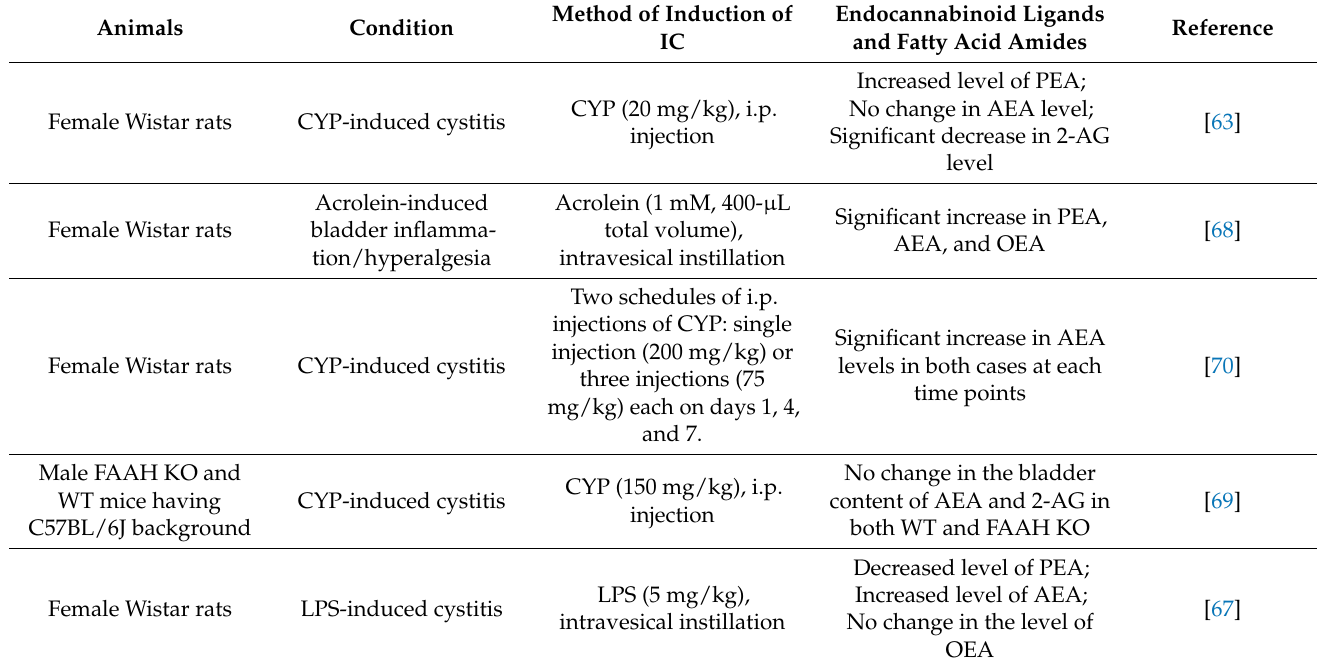
Table 2. Endocannabinoid Ligands and Fatty Acid Ethanolamides in the Bladder Tissue of Experi- mental IC/BPS